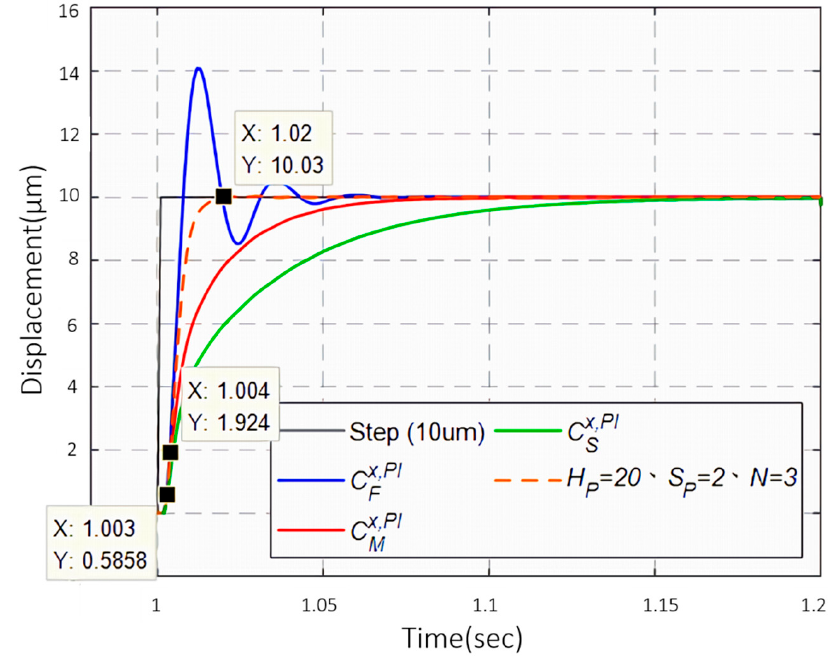
Figure 6. Step response of PZT stage employing the optimal switching control.